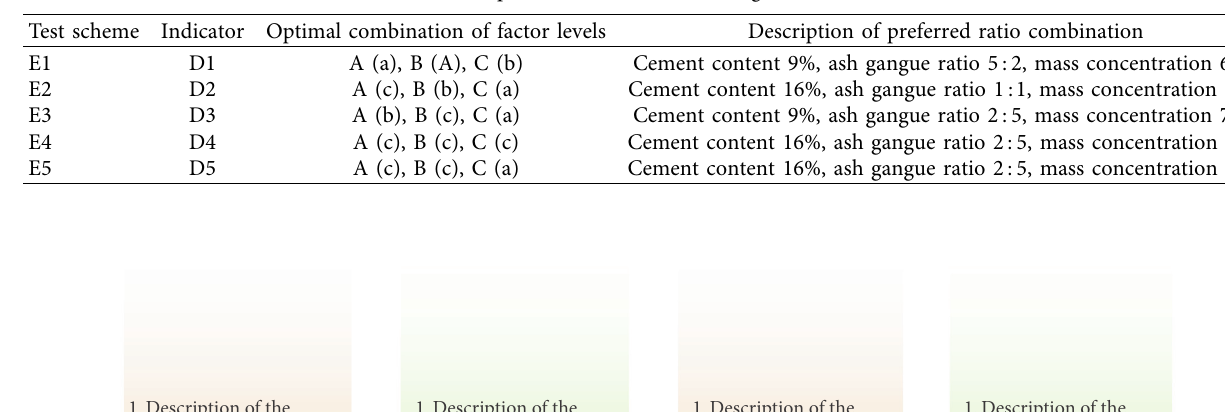
Table 2: Optimization scheme of filling material ratio.